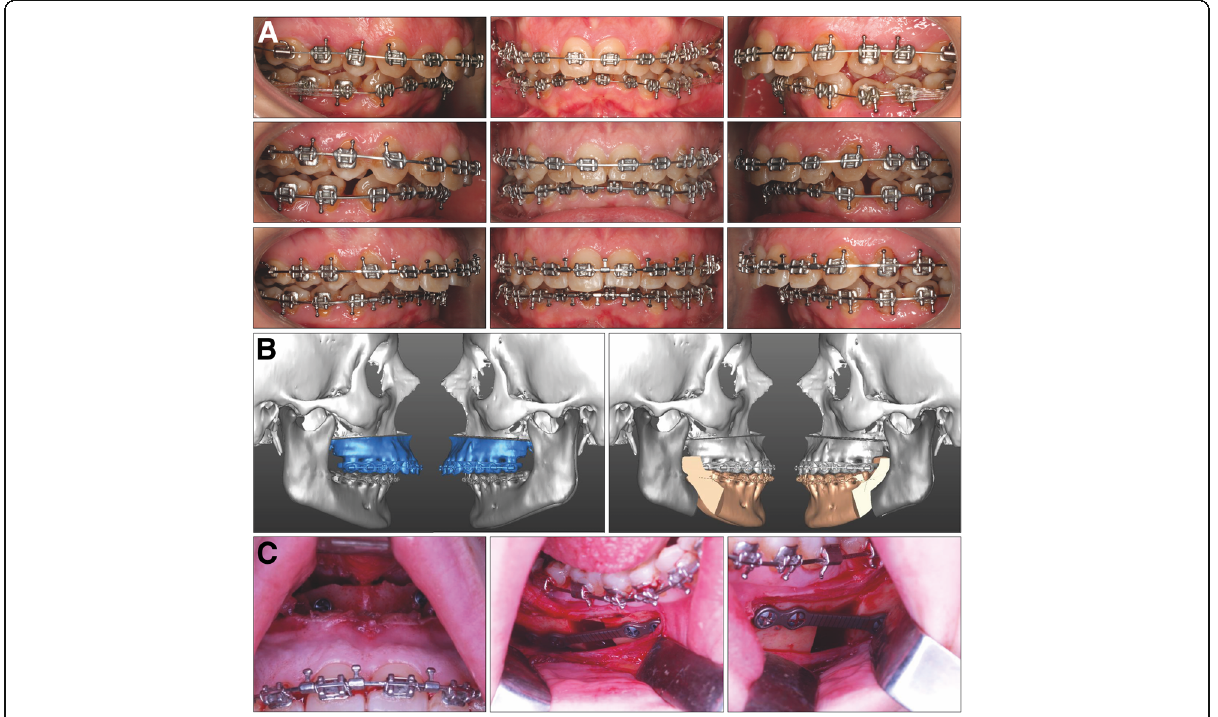
Fig. 2 a Presurgical orthodontic decompensation with mandibular miniscrews. b Surgical treatment plan generated by SimPlant software. c Trans-surgical photographs showing septoplasty, LeFort I osteotomy, and bilateral sagittal split osteotomy for mandibular